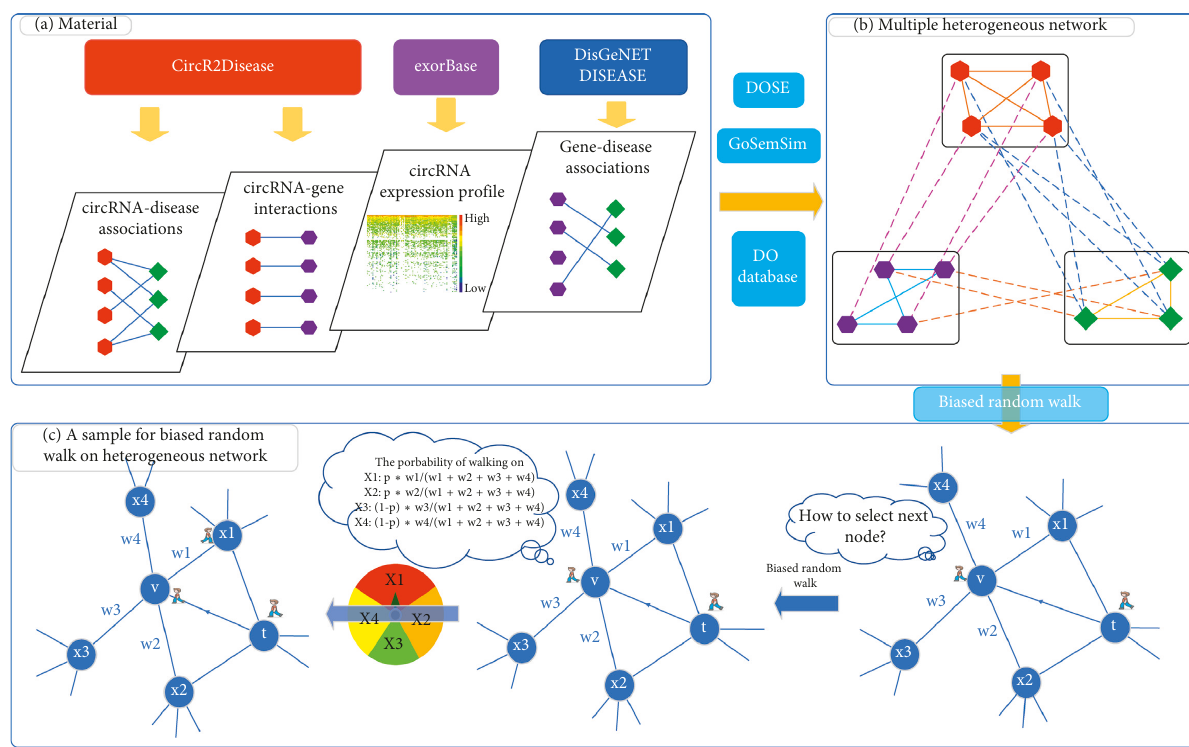
Figure 1: The framework of BRWSP. (a) Some original data are downloaded from corresponding databases. (b) A multiple heterogeneous network is constructed. (c) Biased random walk algorithm runs on a heterogeneous network to find paths between a specific circRNA and a specific